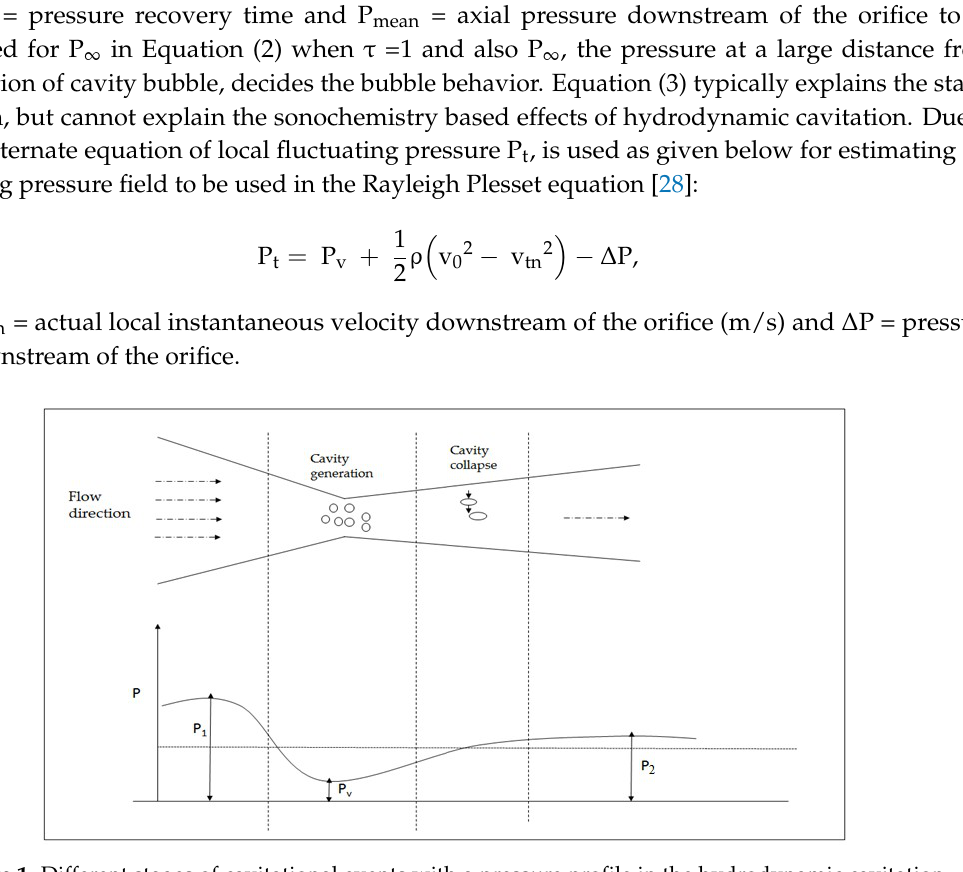
Figure 1. Different stages of cavitational events with a pressure profile in the hydrodynamic cavitation (HC) reactor.